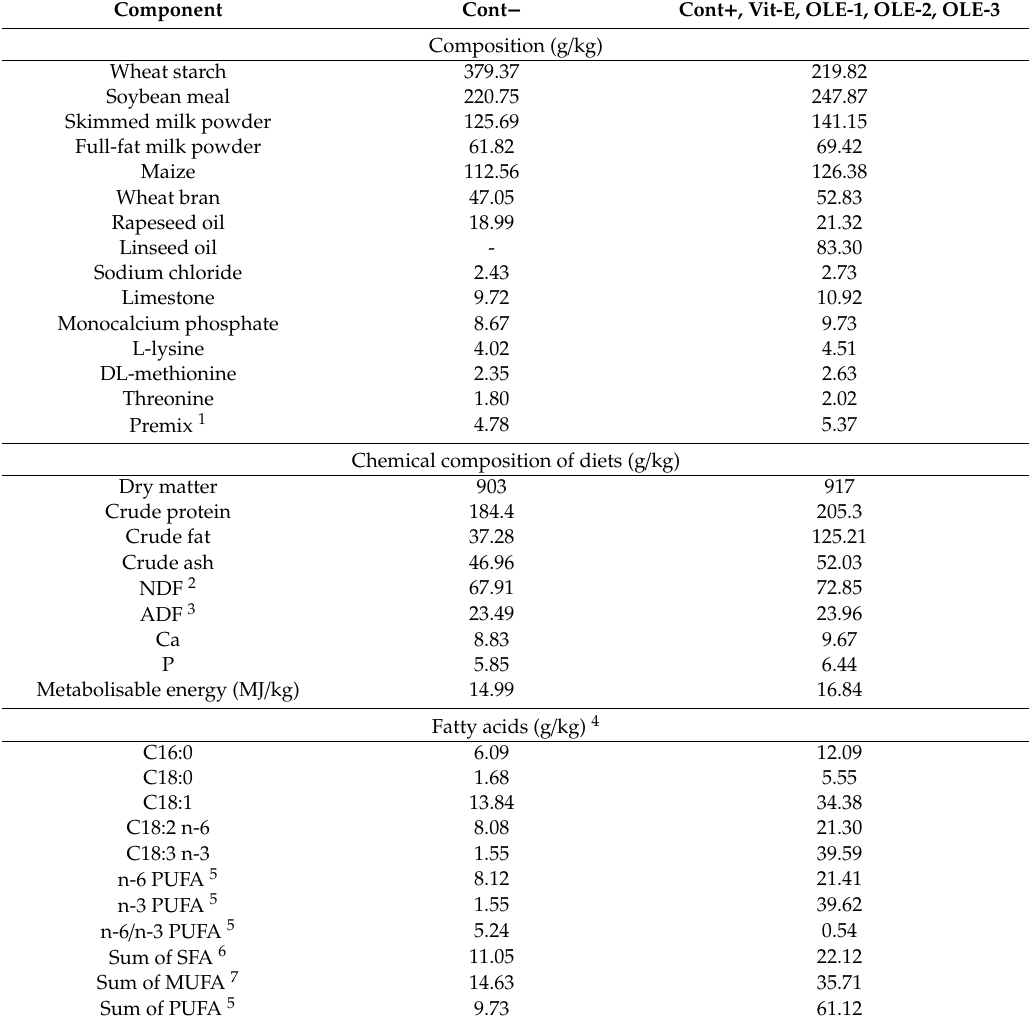
Table 1. Composition, analyses and fatty acid content of the experimental diets.